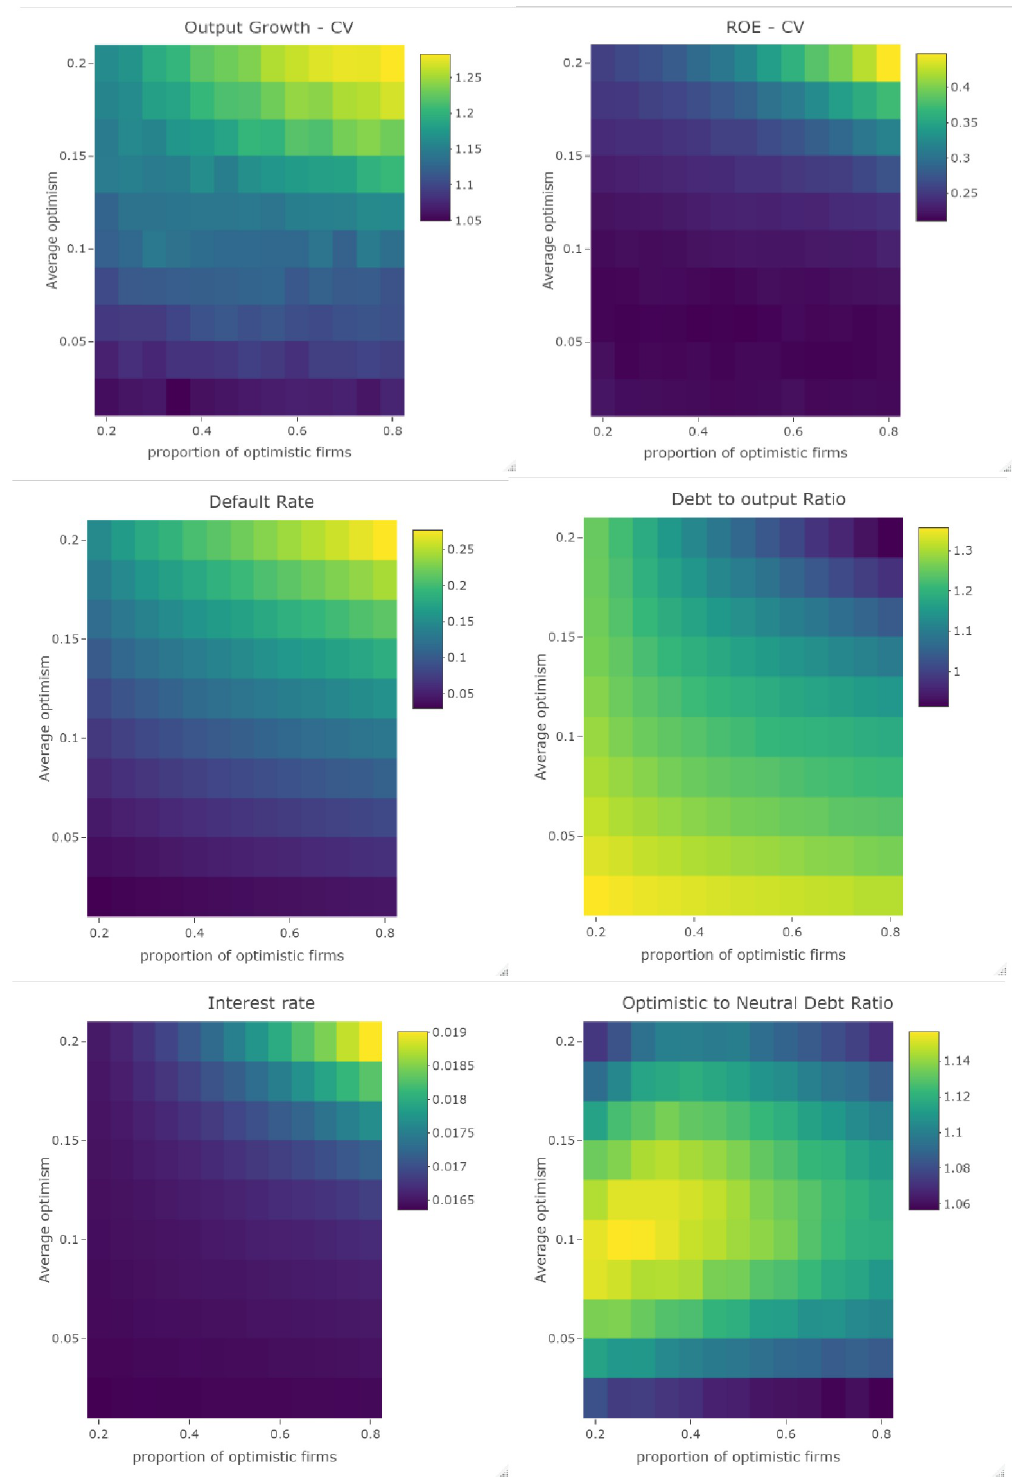
Fig 6. GDP growth coefficient of variation and return on equity, C-firms probability of default, debt to output ratio and interest rate as a function of the proportion of overconfident firms (X axis) and their degree of overconfidence (Y axis). Blue (respectivelly yellow) denotes lower (respectivelly higher) values for the given